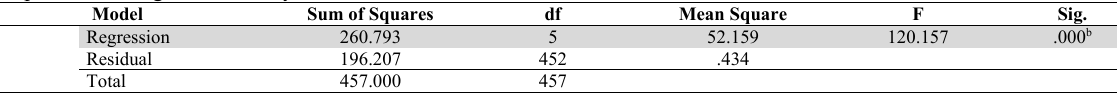
Multiple Linear Regression Analysis: ANOVA Result